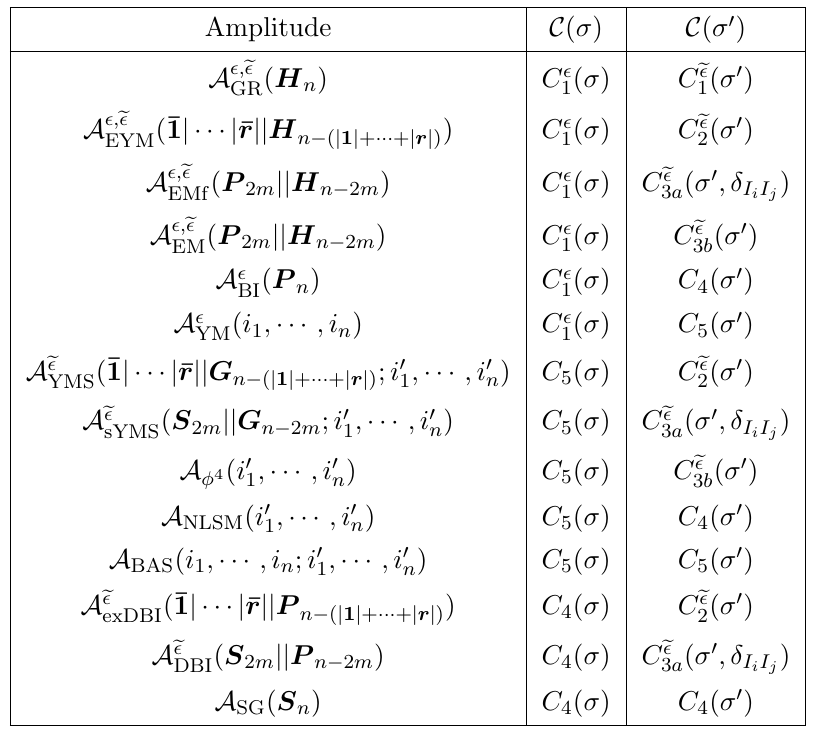
Table 2 . Unifying relations for